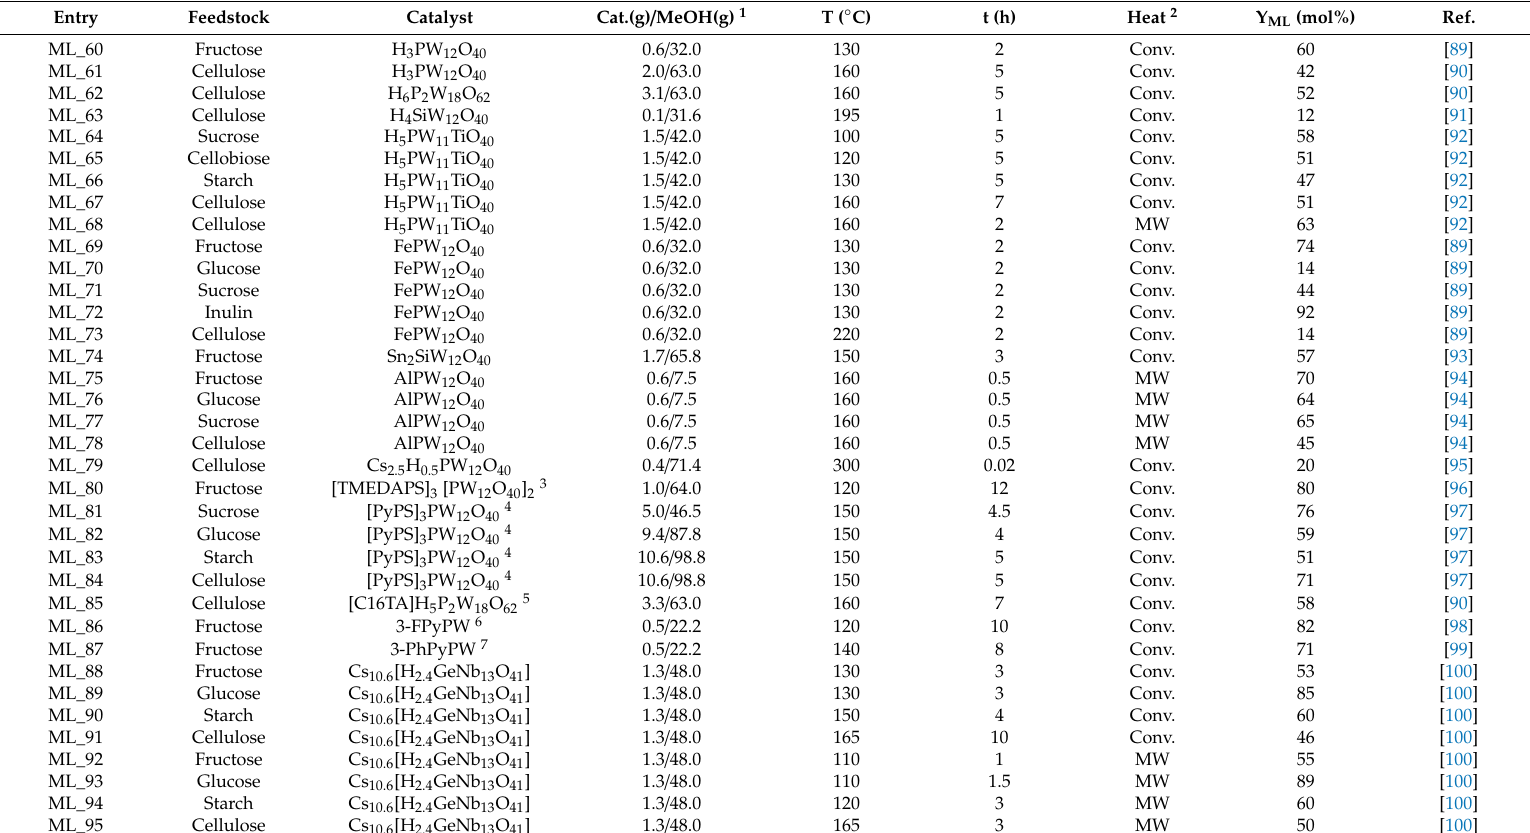
Table 3. Polyoxometalate (POM)-based catalysts for the ML production from C6 model